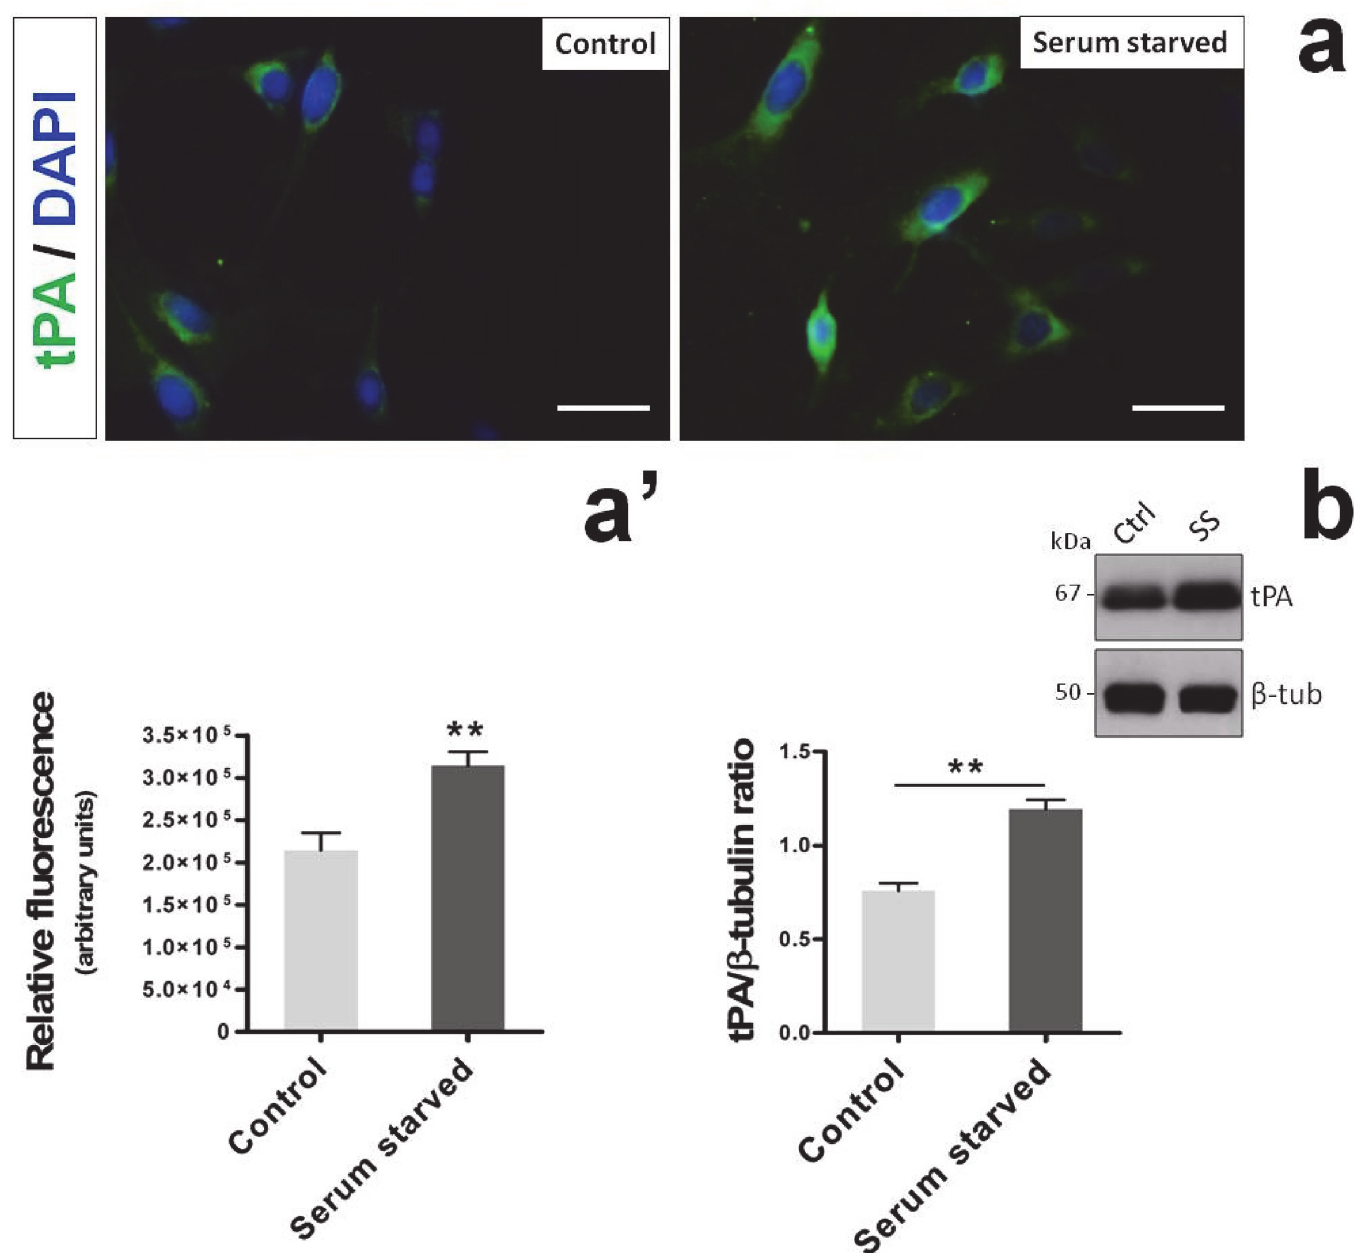
Fig. 6. Serum withdrawal induces tPA expression in RT4-D6P2T cells. Photomicrographs ( a ) and relative quantifications of tPA-like immunoreactivity in RT4-D6P2T cells ( a ’ ) cultured either in the presence (Control) or absence of serum (Serum Starved) after 24h. Immunofluorescent images were captured using an Axiovert 40 fluorescence microscope (Carl Zeiss Inc.). Each condition was reproduced using at least three dishes per experiment. Representative photomicrographs were taken from at least three fields per dish in a fixed pattern. Original magnification 40X. Scale bar = 30 μ m. Details on the procedure can be found in MATERIALS AND METHODS section. ( a ’ ) Bar graph depicts the relative fluorescence ± SEM, expressed as arbitrary units. ** p < 0.01 Vs Control , as determined using the unpaired two-tailed Student t -test. ( b ) Representative immunoblot and related quantifications of bands obtained by resolving cell lysates from cultures treated as indicated above. Normalized tPA expression levels were calculated using β -tubulin as the loading control. Each result displayed in the bar graph represents the mean ± SEM from three independent experiments. ** p < 0.01 Vs Control ; Unpaired two-tailed Student t -test. Ctrl = 10% FBS cultured RT4-D6P2T cells after 24h. SS = Serum starved